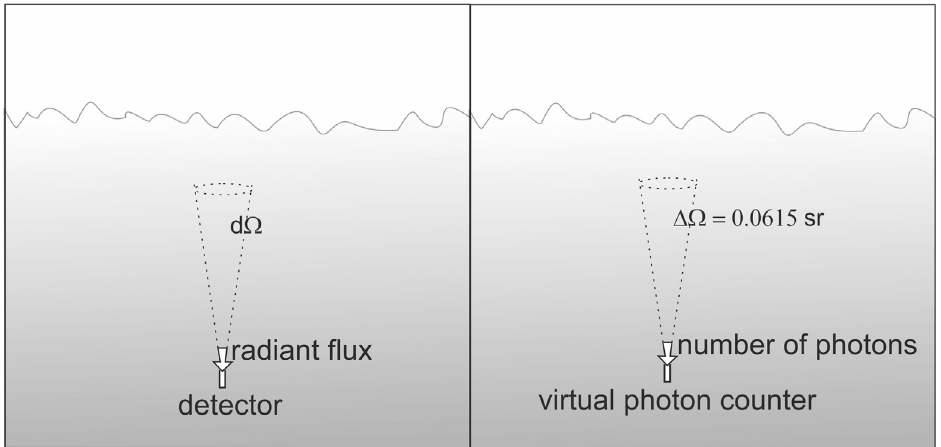
Figure 4. Implemented geometry of radiance measurement in relation to the definition of radiance ( left ) and the geometry of functioning of a solid angle virtual receiver ( right ).